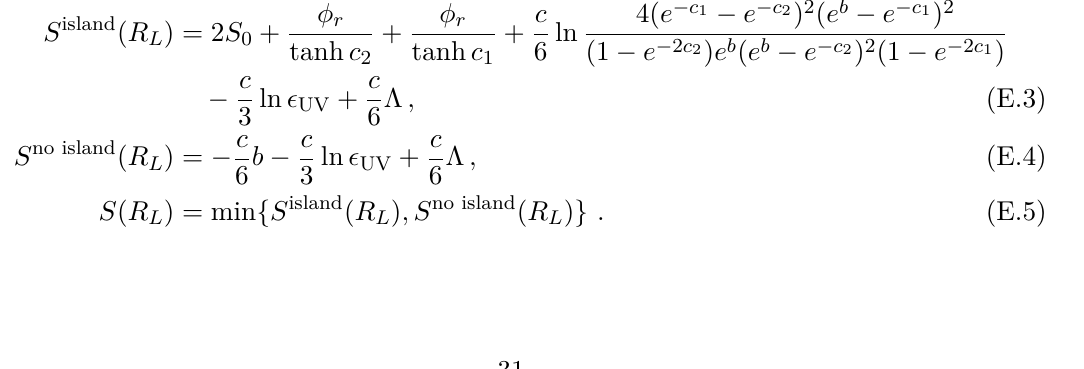
Figure 29 . Radiation and black hole on one side. The point ( − d, − t + πi ) is the quantum extremal surface of the black hole. The island of radiation is the interval bounded by the points ( − c 1 , − t + πi ) and ( − c 2 , − t + πi )